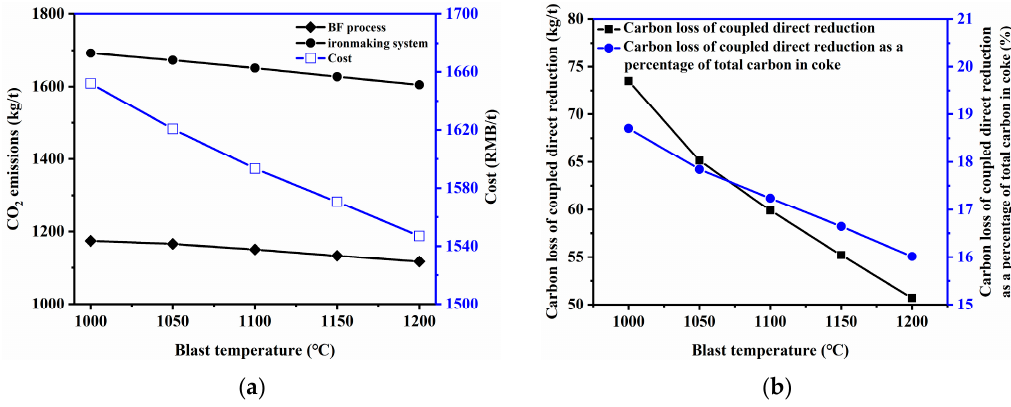
Figure 3. ( a ) Effect of blast temperature on cost and CO 2 emissions; ( b ) Effect of blast temperature on carbon loss of coupled direct reduction and its percentage of total carbon in coke.